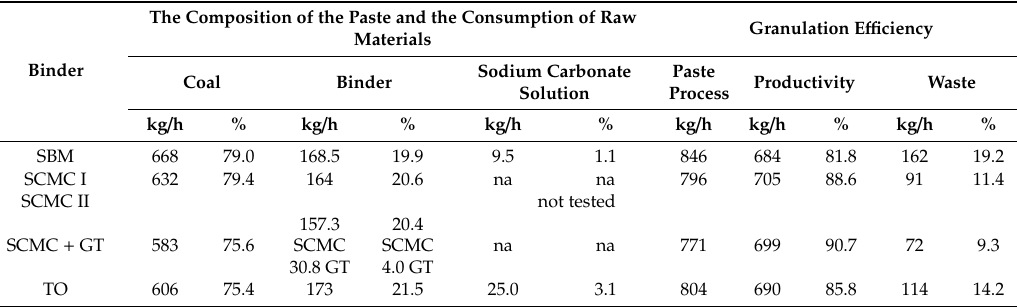
Table 1. Raw material consumption and granulation e ffi